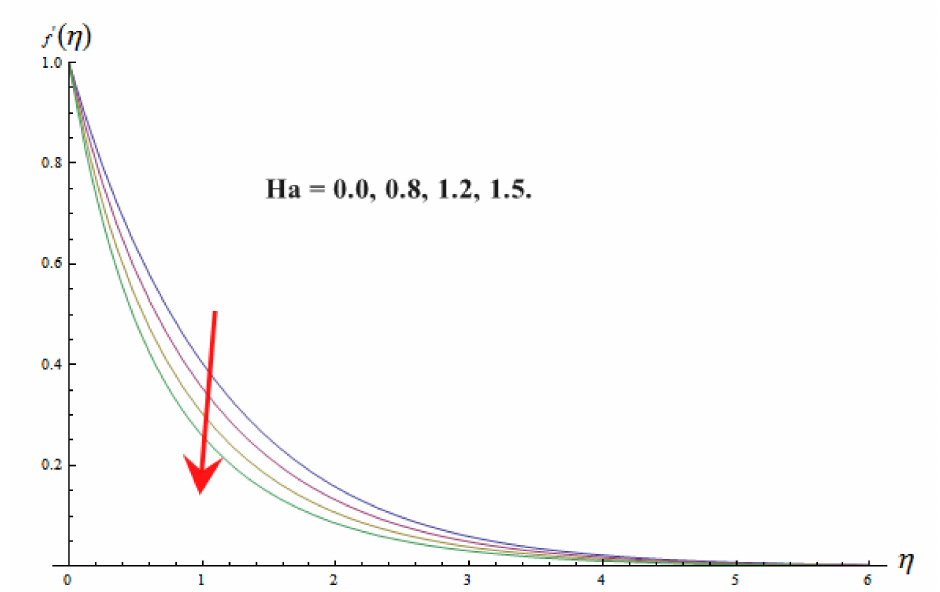
Figure 2. Impact of Ha on f (cid:48) ( η ) keeping Γ = 0.5, Pr = 2, Br = 2, λ = 2, Ec = 0.2, Rd = 2, β 1 = 0.2, λ 1 = 0.2, K ∗ =